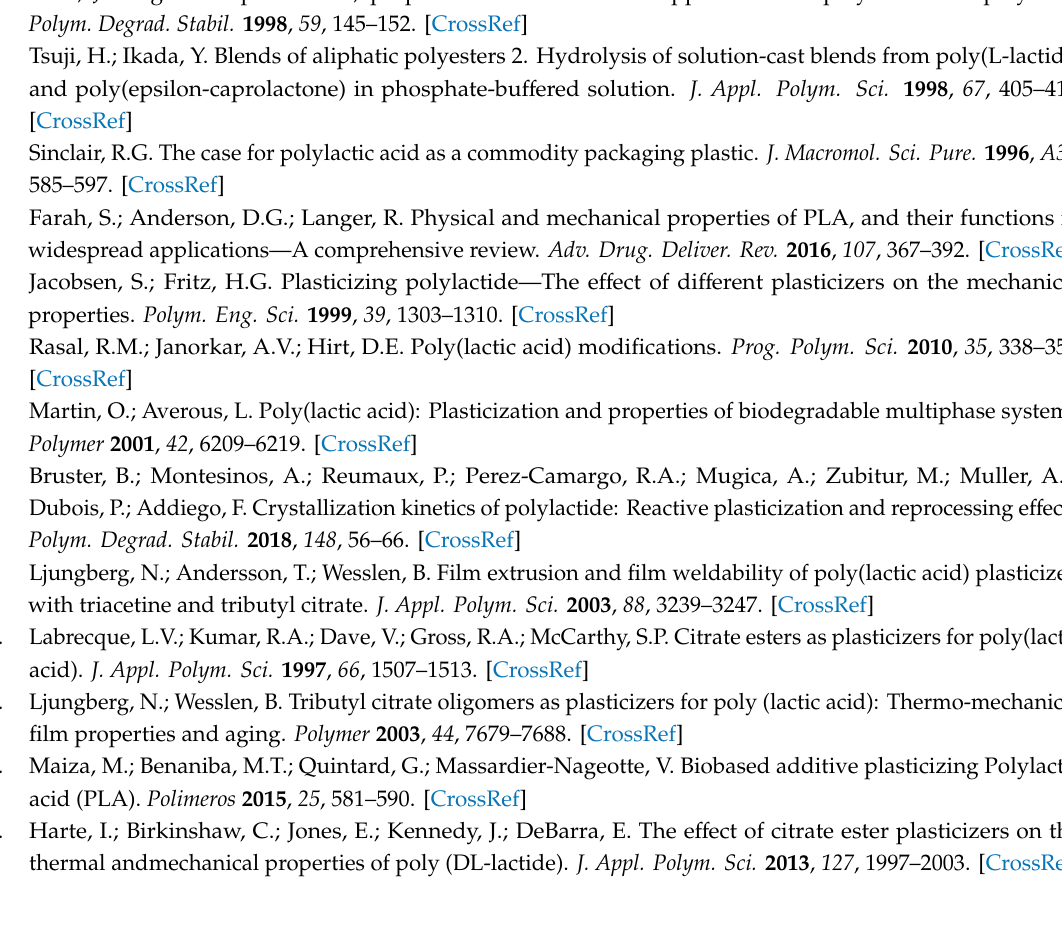
Figure S1: Kinetics of triethyl citrate sorption by polylactide film. Figure S2: TGA thermograms in air for polylactide (PLA), triethyl citrate (TEC), and their blends. Figure S3: Kinetics of triethyl citrate desorption for PLA / TEC systems samples. Figure S4: 1D SAXS patterns of polylactide (PLA), polylactide / triethyl citrate system (PLA / TEC_SS), and polylactide / triethyl citrate system after plasticizer removal (PLA /